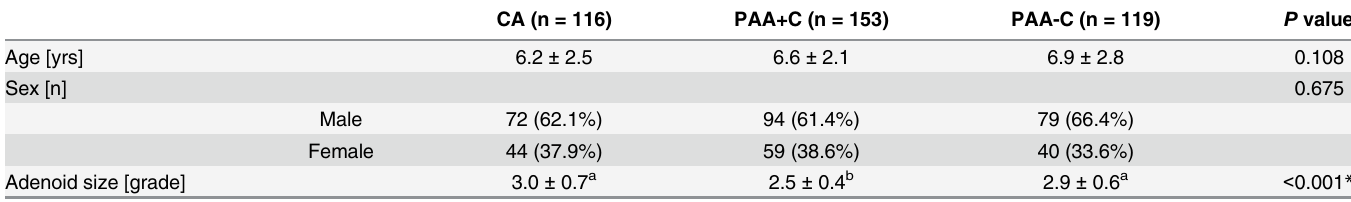
Data are presented as mean ± standard deviation; CA, Coblation Adenoidectomy; PAA+C, Power-Assisted Adenoidectomy with Cauterization; PAA-C, Power-Assisted Adenoidectomy without